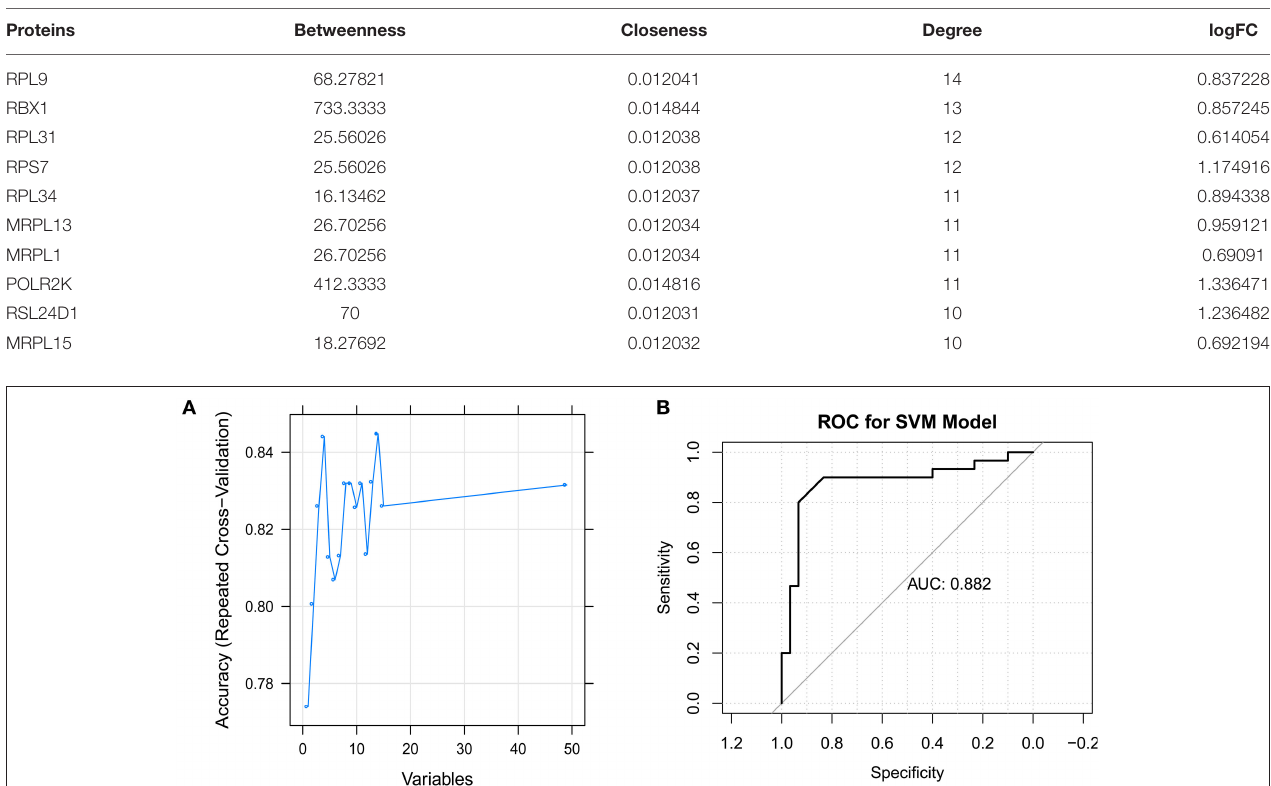
TABLE 2 | Degree of proteins (top 10) in the protein–protein interaction (PPI) network. Proteins